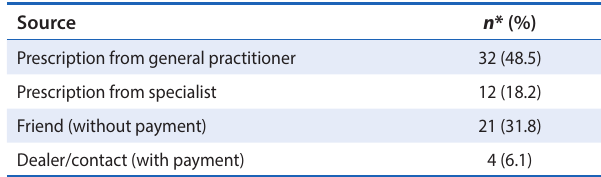
*More than one option could be